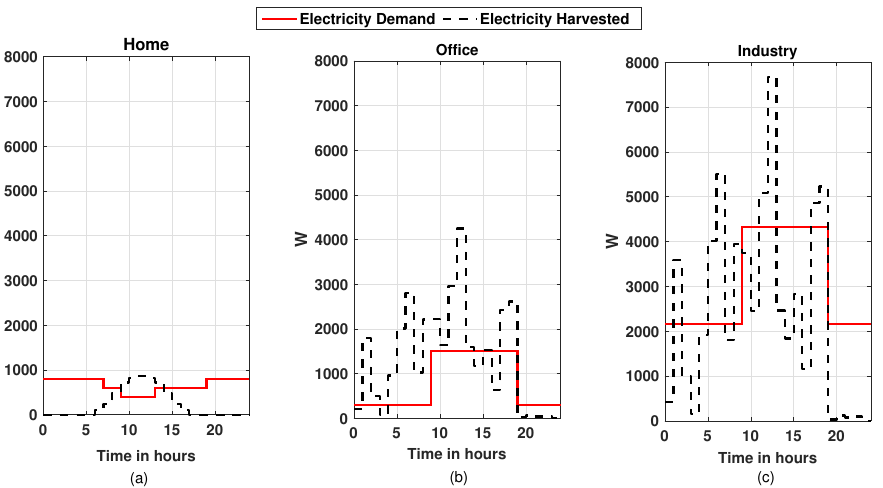
Figure 8. Electricity demand and harvested electricity of 24 h for the month of June, ( a ) for the home building, ( b ) for office building, and ( c ) for industry